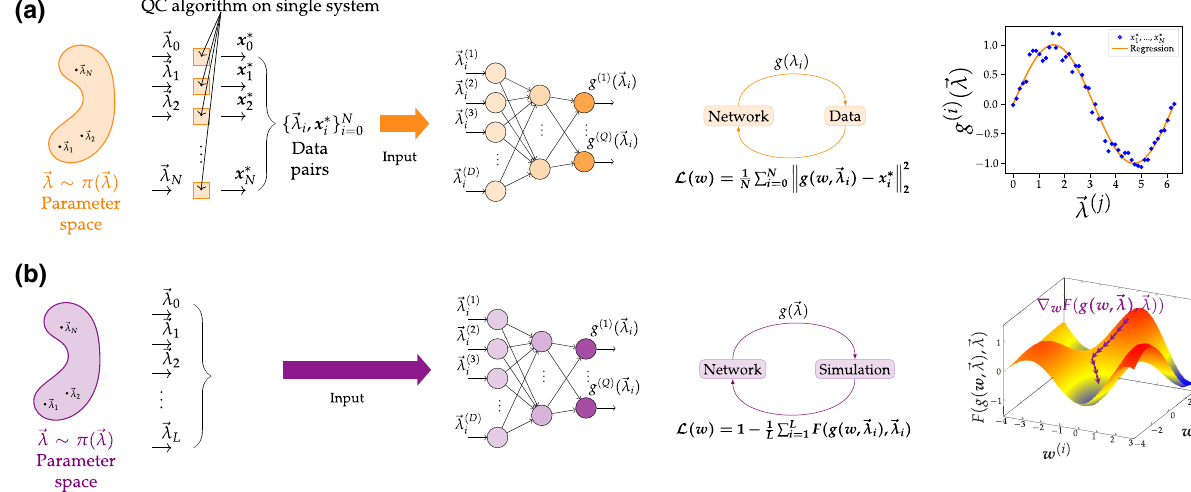
FIG. 2. The SOMA gate-synthesis method represented in its two variants. (a) In SOMA SL, we first optimize N different QOC problems with different problem parameters (cid:4) λ 1 , (cid:4) λ 2 , . . . , (cid:4) λ N using an optimal quantum control algorithm such as in Refs. [41,42,50,51] , x ∗ , . . . , x ∗ and then using a function approximator to learn the mapping g : R D (cid:2)→ R Q , (cid:4) λ −→ x ∗ ( (cid:4) λ) between to obtain optima x ∗ N 1 2 the problem parameters and the optimal pulses. (b) In SOMA BP, we sample L OQC problems (cid:4) λ 1 , (cid:4) λ 2 , . . . , (cid:4) λ L and train the function approximator to minimize the average infidelity of the ensemble of problems using back propagation, without generating optimal solutions for a single problem with a standard quantum control